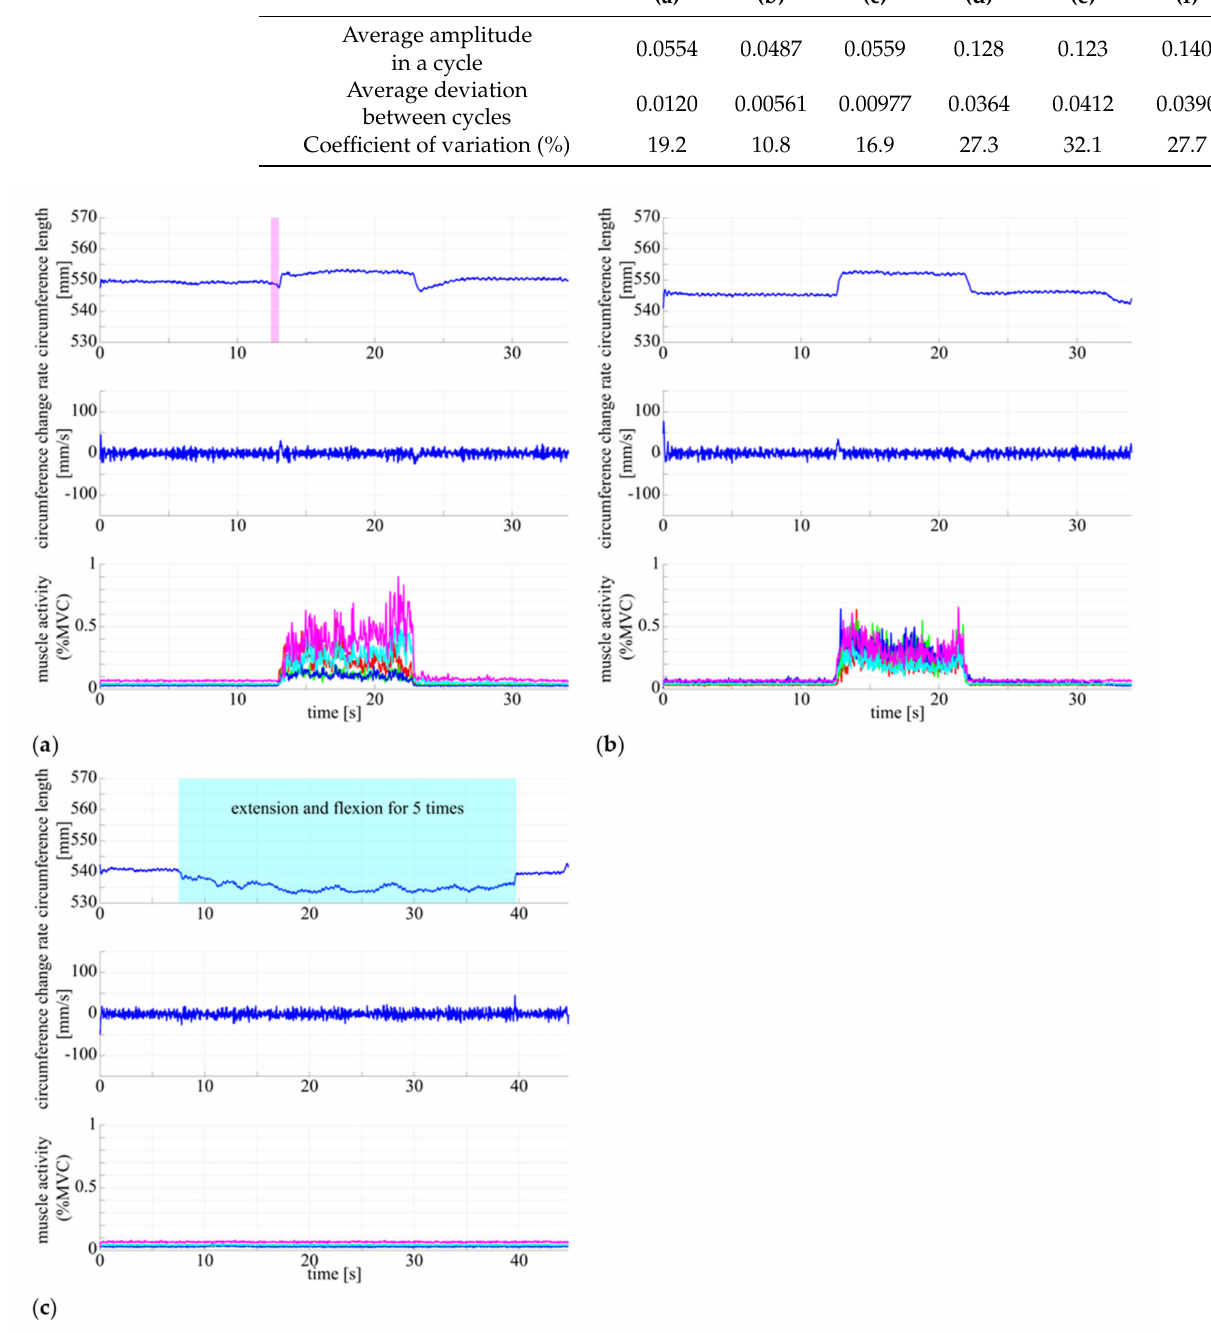
Figure 5. Circumference length, velocity, and muscle activity of ( a ) co-contraction during static standing position, ( b ) co-contraction during sitting position, and ( c ) relaxation during passive extension and flexion of knee joint (5 times during the middle of sequence). The horizontal axis represents time (s) and the vertical axis represents the stretch length (mm) in top, stretch velocity (mm/s) in middle, and muscle activity normalized by MVC in bottom. The red and green lines represent vastus lateralis and vastus medialis, respectively; the blue, cyan, and magenta lines represent rectus femoris, biceps femoris long head, and bicep femoris short head,